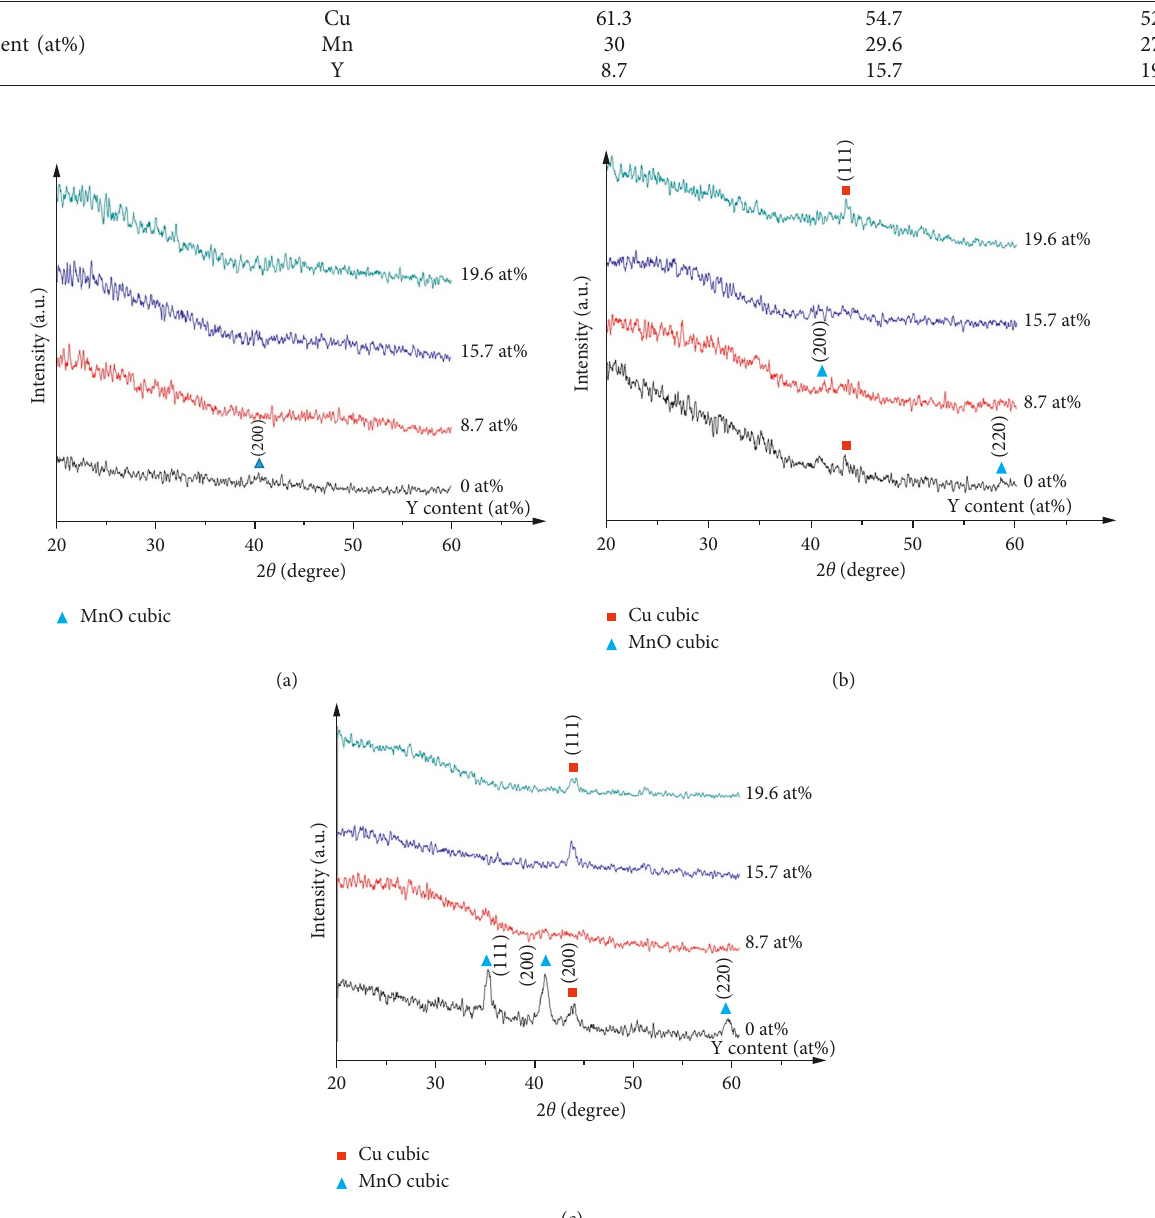
Figure 1: CuMnY thin-film X-ray diffraction patterns with various amounts of yttrium addition annealed at (a) 250 ° C, (b) 300 ° C, and (c) 350 °